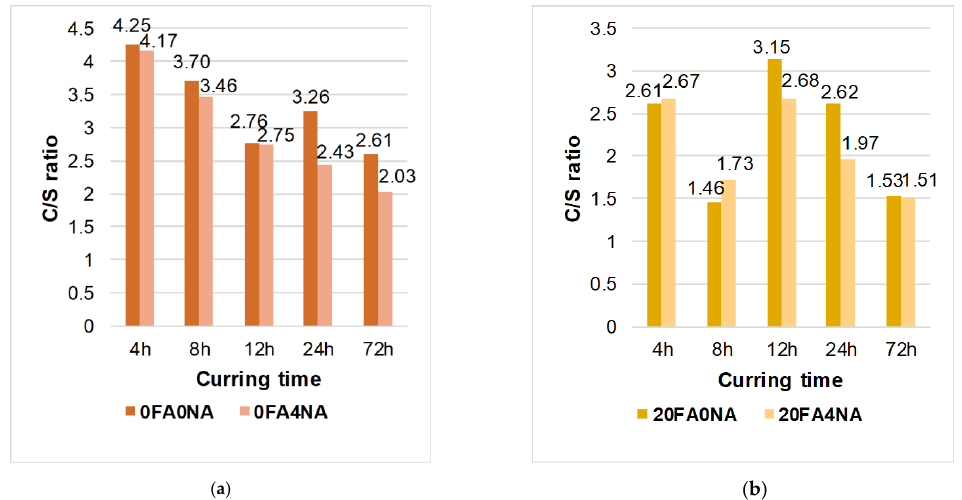
Figure 6. SEM–EDS results for the 20FA0NA ( a ) and 20FA4NA ( b ) after 8 h of curing.